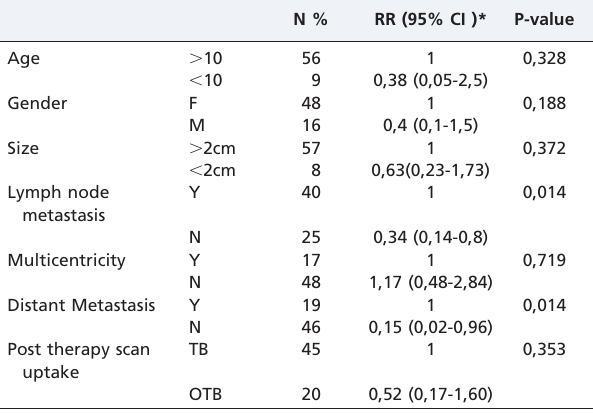
Table 2 - Staging systems and prediction of good response to initial therapy.